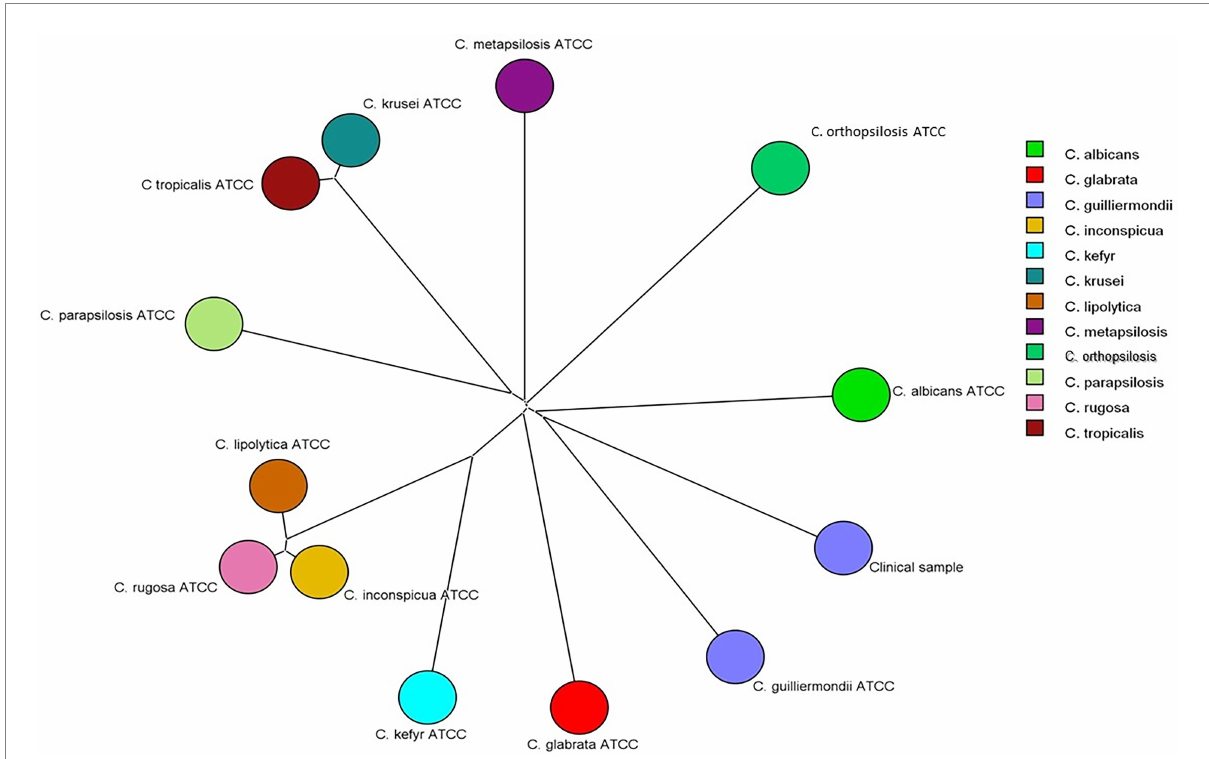
FIGURE 2 Neighbor-Joining tree based on Pearson correlation constructed with MALDI-TOF MS spectra of the clinical isolate and of reference strains of Candida albicans (ATCC 18804), Candida glabrata (ATCC 2001), Candida guilliermondii (ATCC 7350), Candida inconspícua (ATCC 16783), Candida kefyr (ATCC 4135), Candida krusei (ATCC 6258), Candida lipolytica (ATCC 18942), Candida metapsilosis (ATCC 96143), Candida orthopsilosis (ATCC 96141), Candida parapsilosis (ATCC 22019), and Candida rugosa (ATCC